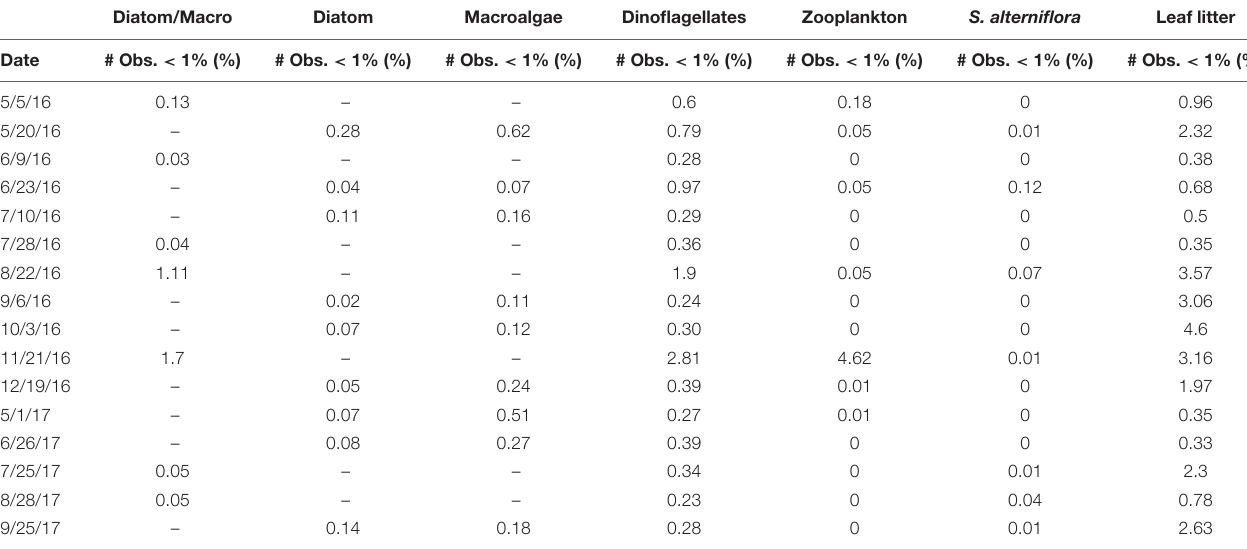
TABLE 4 | The proportion (%) of Bayesian mixing model iterations (30 × 10 3 ) that estimated zero contribution ( < 1%) for each endmember (Diatom, dinoflagellate, zooplankton, macroalgae, Spartina alterniflora , and leaf litter) to the diet of Mytilus edulis in Saco Bay, ME, United States, throughout 2016 and 2017.